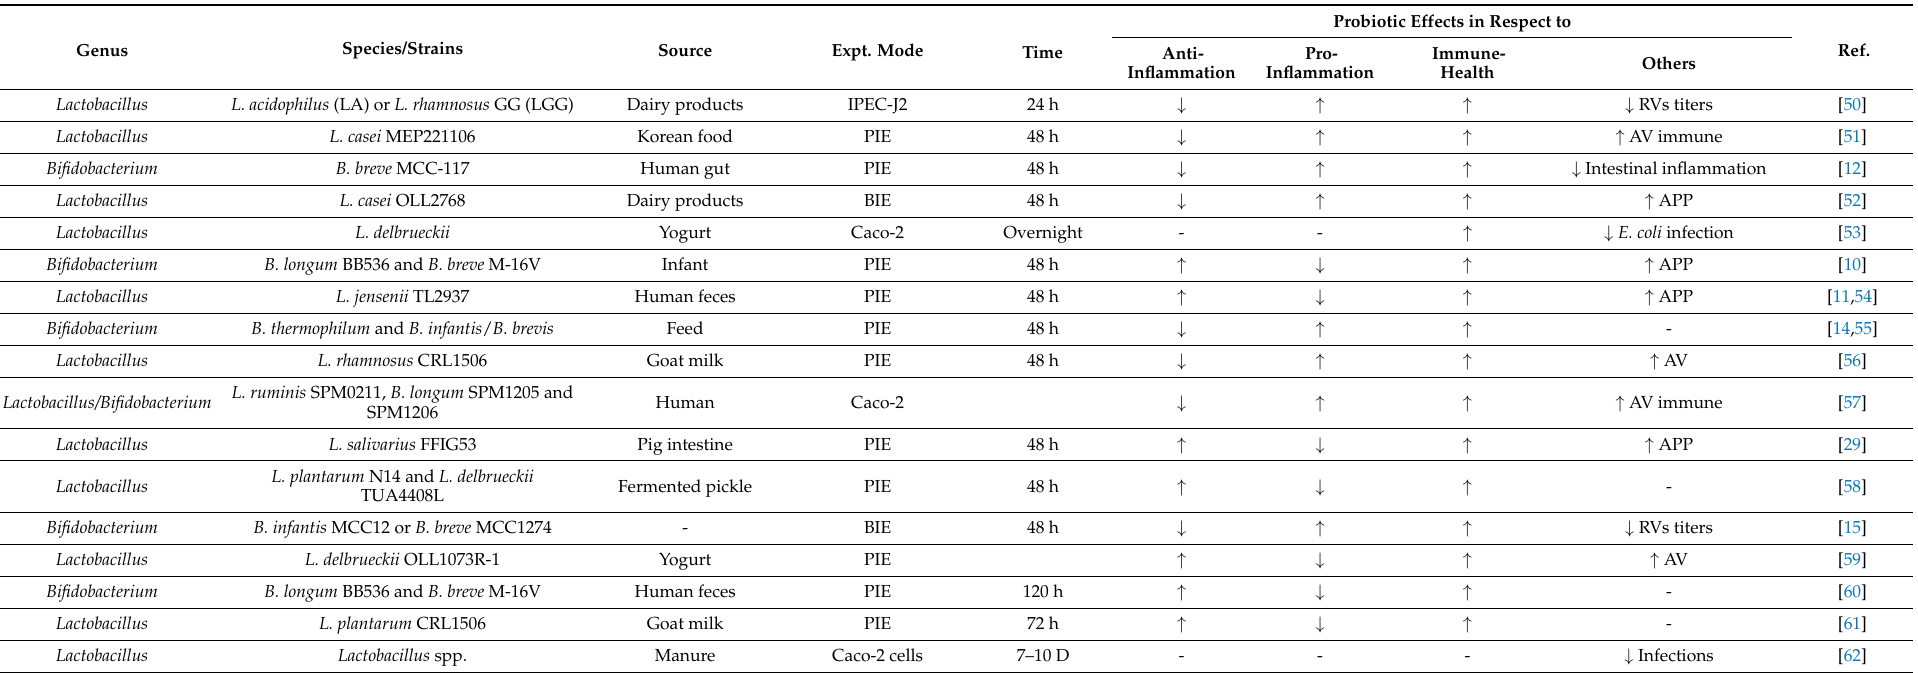
Table 3. Summary of current trials in cell line as livestock animal model (in vitro) measuring the immunoregulatory effects of probiotics.